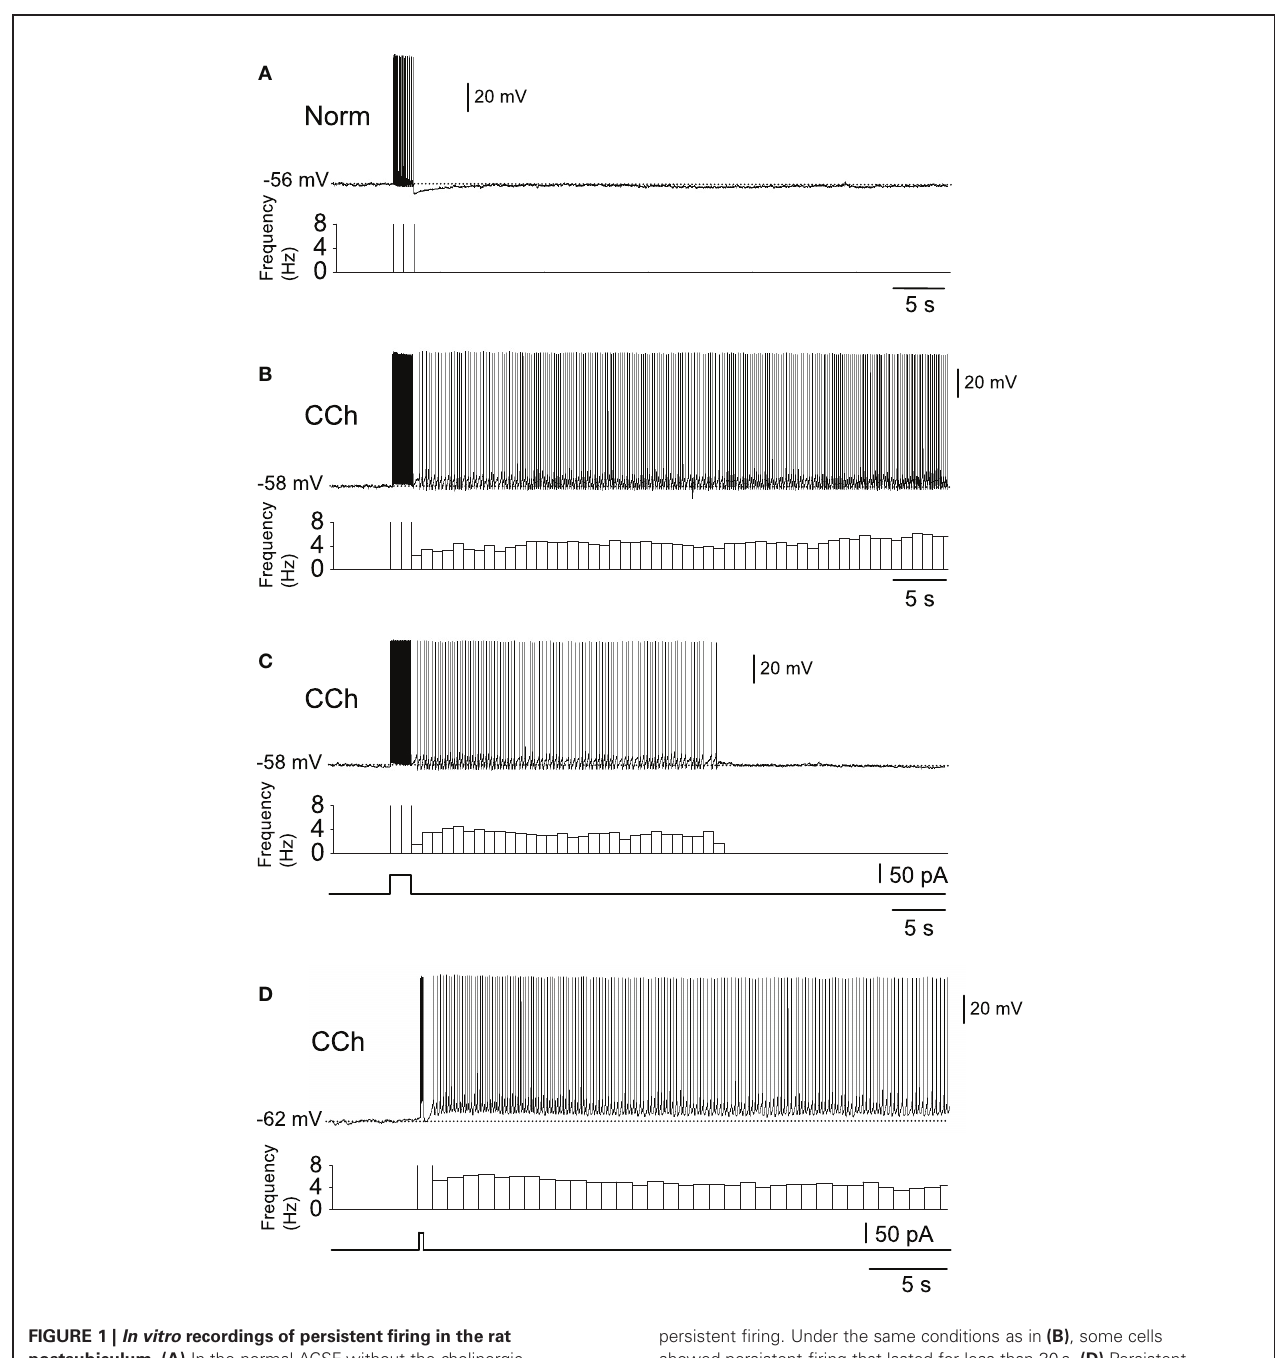
FIGURE 1 | In vitro recordings of persistent firing in the rat postsubiculum. (A) In the normal ACSF without the cholinergic receptor agonist carbachol, a brief current injection (2s, 50 pA) elicited action potentials only during stimulation. (B) Long-lasting persistent firing. In the presence of carbachol (10 μ M), the same current injection caused stable sustained firing lasting several minutes. (C) Self-terminating